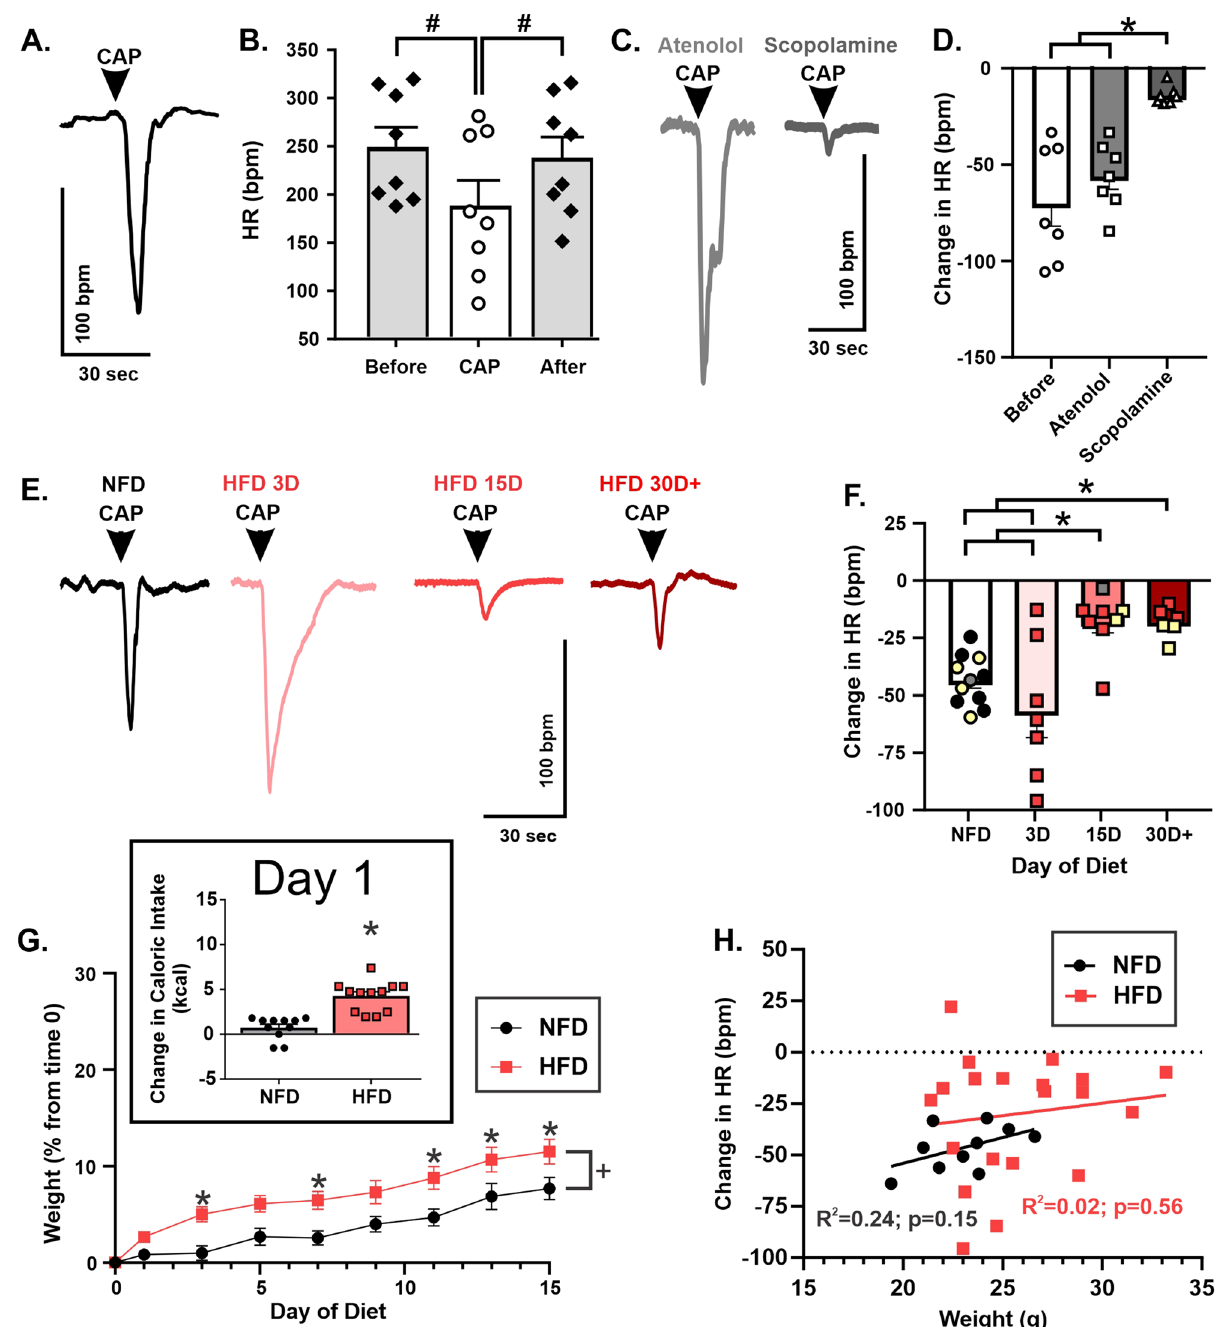
Figure 1. Capsaicin-mediated cardiopulmonary reflex is blunted by HFD. Representative HR responses to i.v. capsaicin ( A ). HR response (beats per minute; bpm) to capsaicin (10 μg/kg; n = 8 mice) ( B ). Representative HR responses after pre-treated with beta-adrenergic receptor antagonist, atenolol (10 mg/kg, i.p.) followed by muscarinic receptor antagonist, methylscopolamine (1 mg/kg; i.p.) ( C ). Mean HR responses to capsaicin were diminished after methylscopolamine, but not atenolol (n = 7) ( D ). Representative HR responses to capsaicin for each diet duration examined ( E ). Mice fed HFD for 15 days (n = 8) or more (n = 6) showed significantly reduced HR responses to i.v. capsaicin compared to NFD (n = 11) and Day 3 (n = 7); Overlaid symbols represent individual responses: yellow denotes animals under isoflurane, grey denotes urethane, all others are ketamine/ xylazine ( F ). Percent change in weight from before start of diet (time 0) for the first two weeks for HFD (n = 11 mice) and NFD (n = 12 mice). Inserted graph illustrates the significant increase in food intake on Day 1 (no other time was significant, see results section for more details) ( G ). Weight on day of experiment did not predict HR responses in either NFD (n = 10 mice) or HFD (n = 20 mice) as determined by a simple linear regression ( H ). # denotes differences from before and after capsaicin (CAP); * denotes significant difference between diets indicated; + denotes significant difference from NFD regardless of